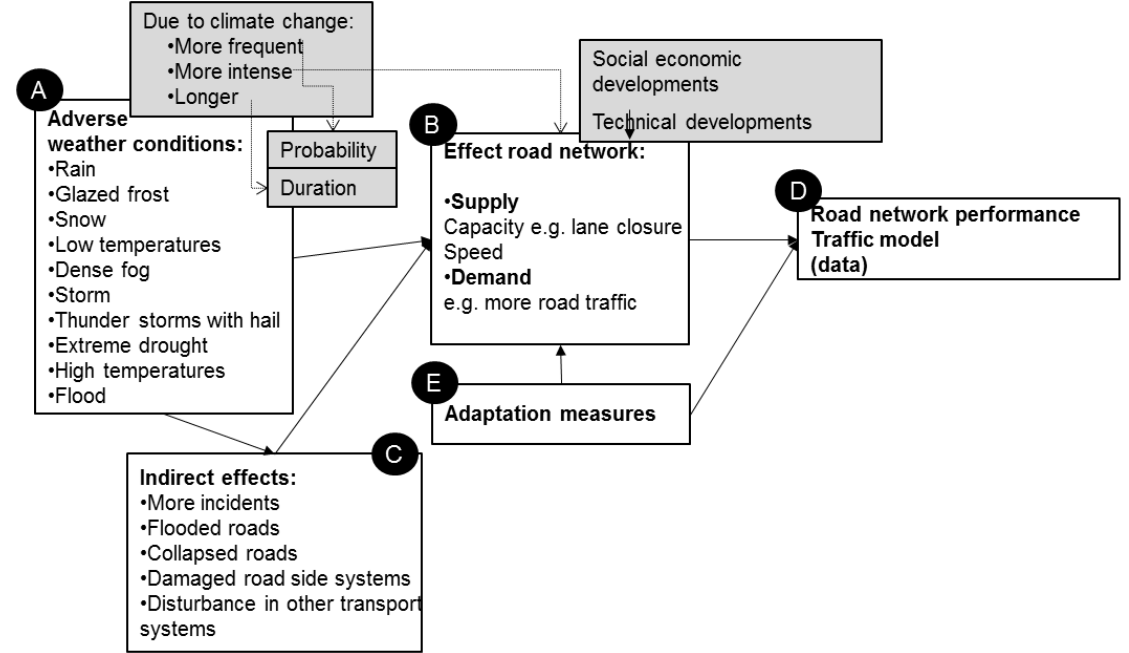
Figure 1. Relationship between adverse weather conditions and the performance of the road